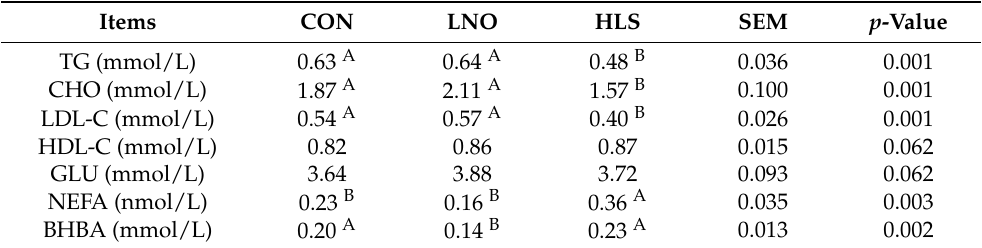
Table 4. The effect of dietary flaxseed oil or flaxseed supplementation on the blood lipid profiles in Albas cashmere goats.